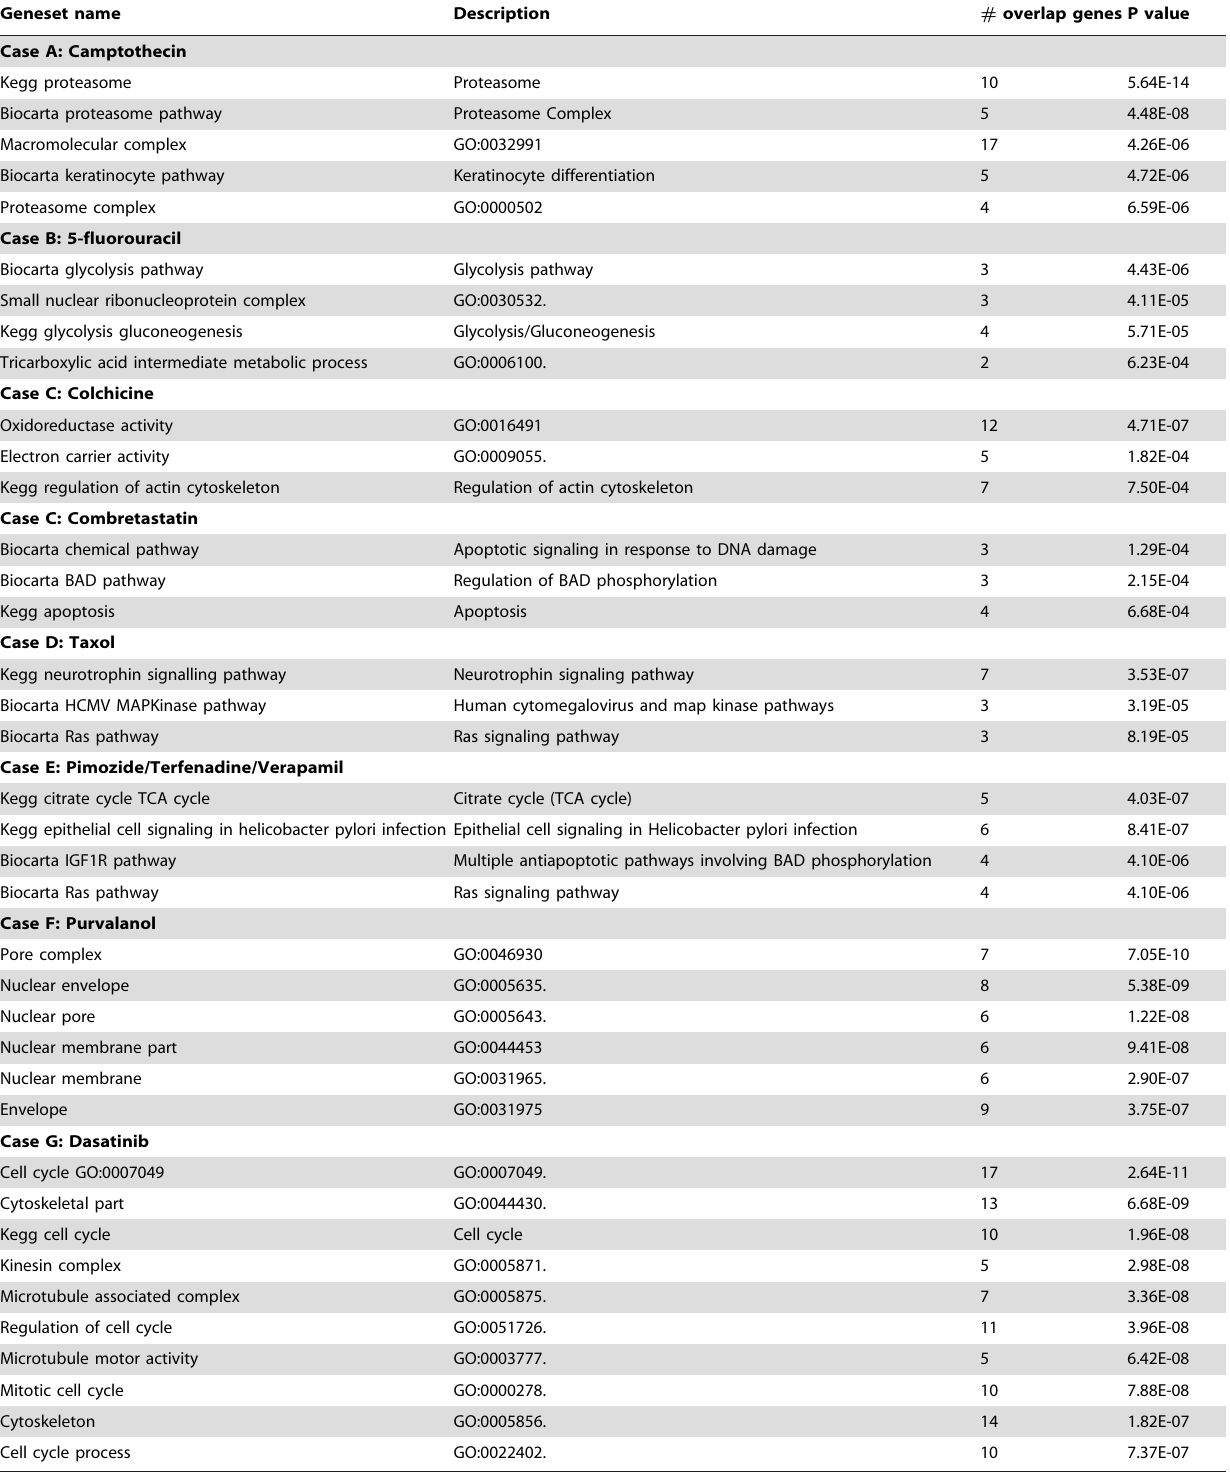
Table 2. GSEA results for test